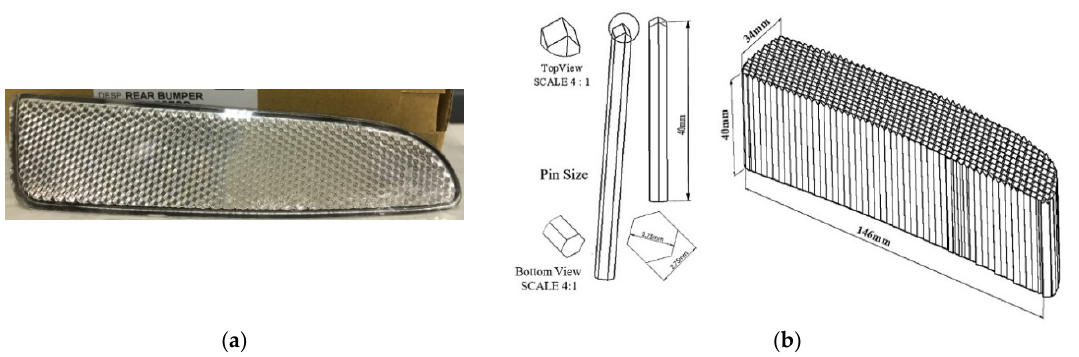
Figure 9. ( a ) The commercial regular curved reflex reflector sample. ( b ) The pin and the primary curved SuperPin Plus reflector design composed of pins.